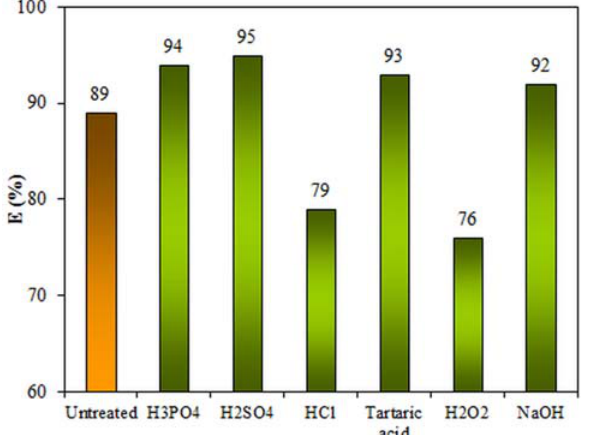
Figure 6. Effect of chemical treatments over the adsorption effi- ciency of MG onto WGT; (296 K, 94 mg/L, 100 mL, 4 g, 200–400 μm, 300 rpm, 240